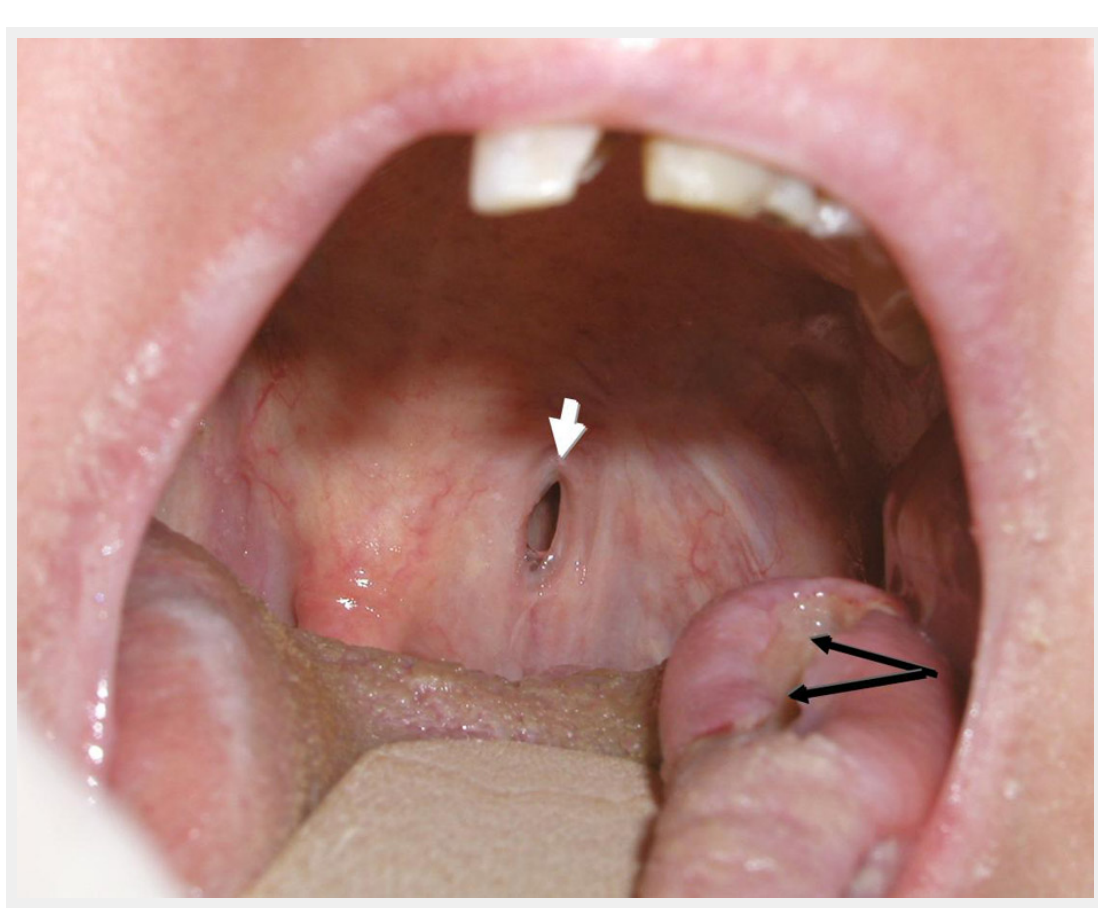
Figure 3 Lateral tongue ulceration (black arrows) and palatal fistula (white arrow) in a patient with